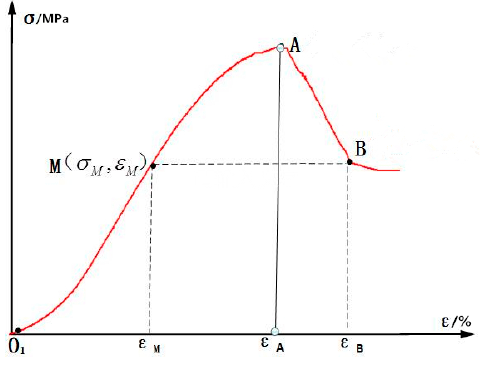
Figure 14. Stress–strain curve of brittle rock [27].